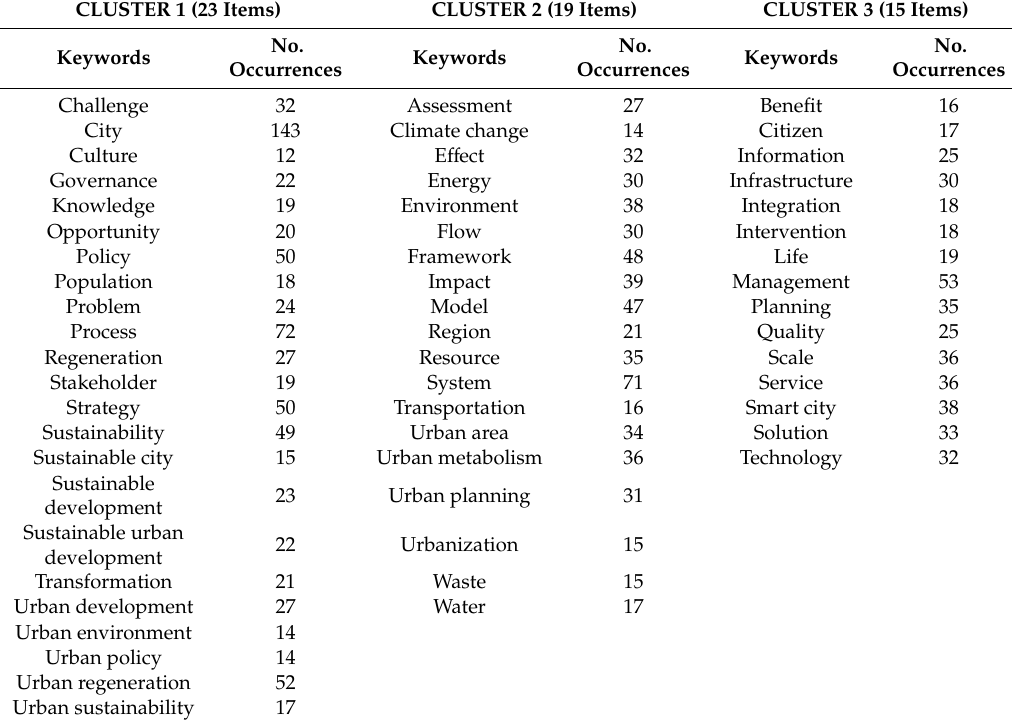
Figure 4. ( a ). Map of co-occurrence analysis based on keywords. ( b ). Map of co-occurrence analysis based on keywords indicating the average of citation. Table 2. Number of co-occurrences of the selected keywords per